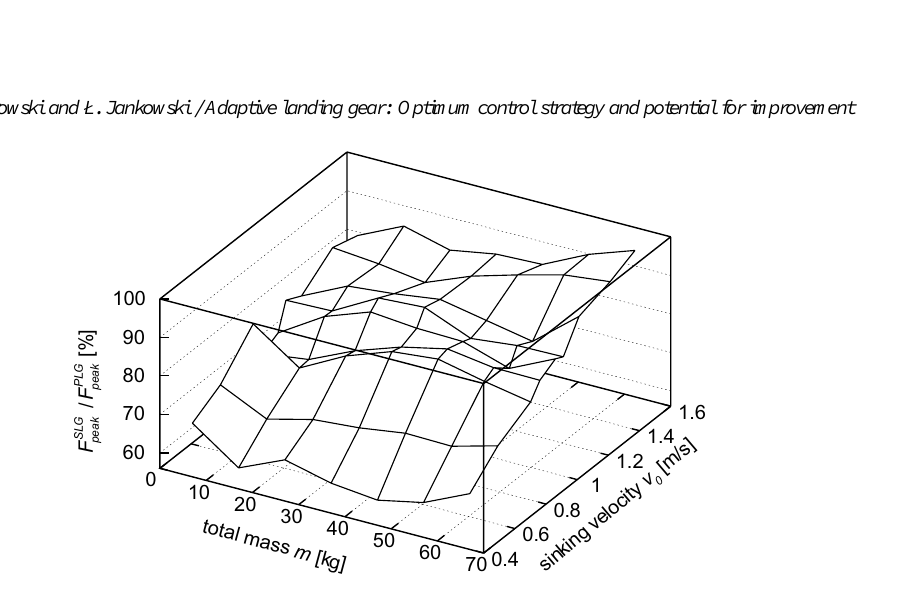
Fig. 19. Semi-active control experimentally compared to passive control: ratio of the measured peak dynamic forces, cf. Fig. 8. signal was determined, which allowed the peak dynamic force to be minimized without reaching the full piston stroke. Further on, the tests were conducted for the full range of the impact energies with the determined level of the damping characteristics. The peak dynamic force was measured and stored to serve as a reference for assessment of the effectiveness of the proposed adaptive control